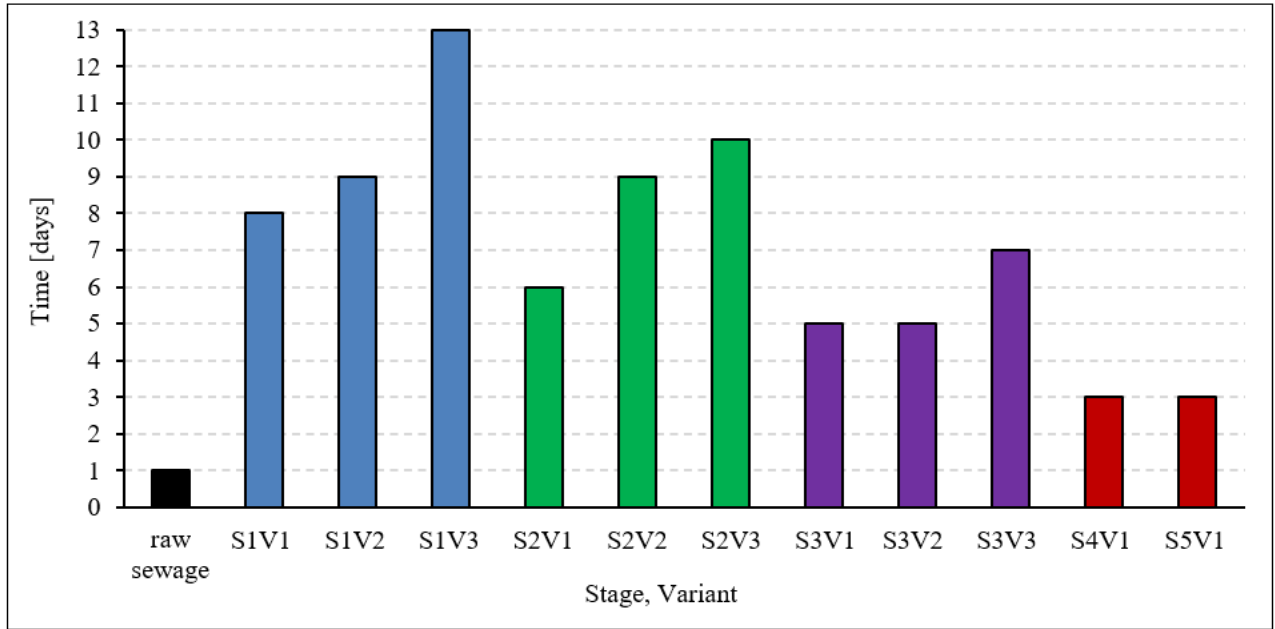
Figure 2. Time-to-putrefaction for wastewater across different variants.